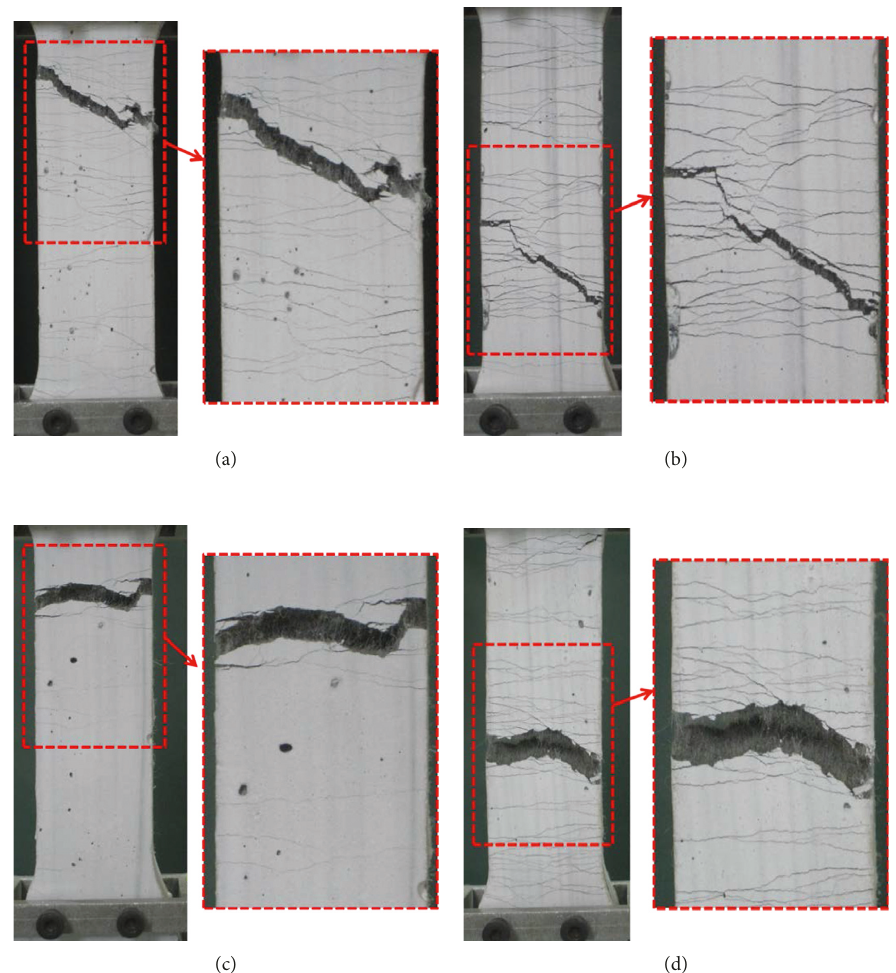
Figure 5: Typical crack patterns after direct tensile tests for each mixture type. (a) SHCC30 mixture. (b) SHCC60 mixture. (c) Ex-SHCC30 mixture. (d) Ex-SHCC60